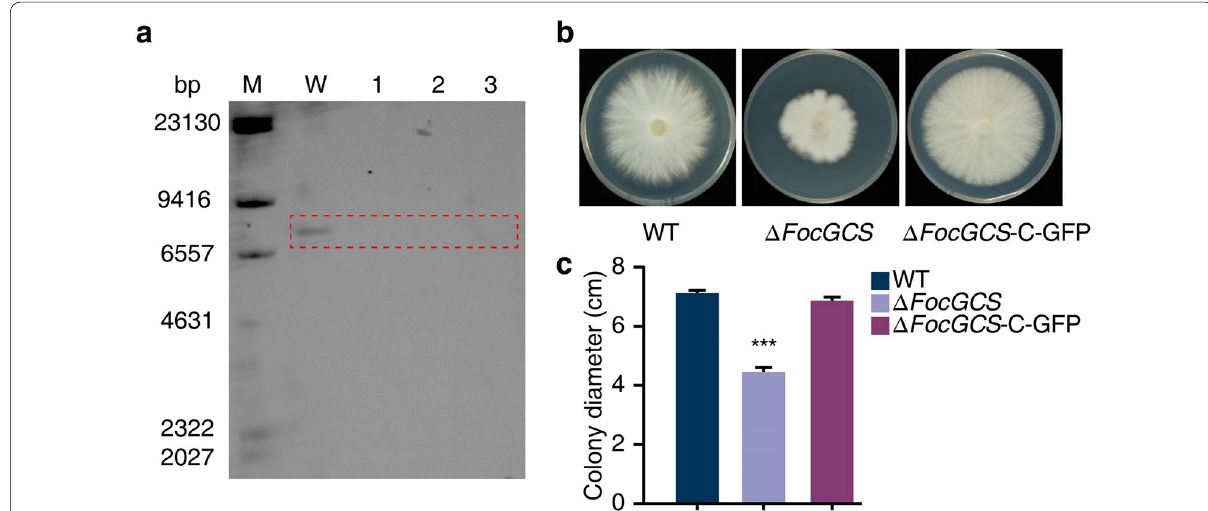
Fig. 2 Southern blot identification and growth phenotype of the ∆ FocGCS mutant. a Southern blot analysis of genomic DNA extracted from the WT and three putative ∆ FocGCS strains and digested with Xba I. b Colony morphology of the WT, ∆FocGCS , and ∆ FocGCS ‑C‑GFP strains on PDA plates. Photos were taken after incubation at 28 °C for 5 days. c Colony diameters of the WT, ∆FocGCS , and ∆ FocGCS ‑C‑GFP strains grown on PDA plates. The mean values SD were calculated from three independent experiments, and asterisks indicate significant differences from the WT group ± (Student’s t ‑test, *** P <